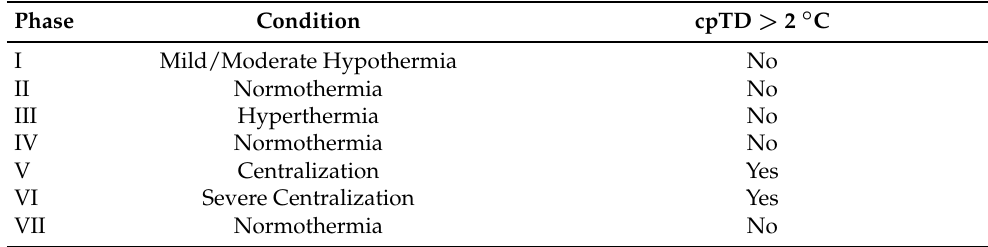
Table 5. Classification of temperature simulation from Figure